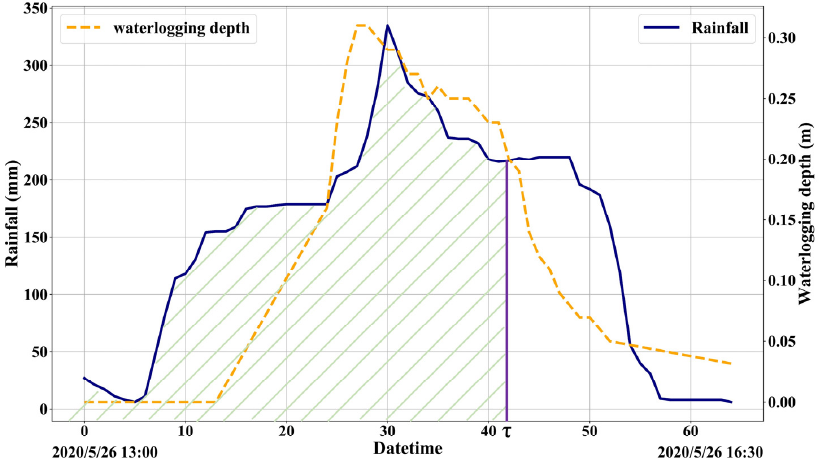
Figure 3. Rainfall process curve and depth of waterlogging (green diagonal part is the cumulative rainfall).